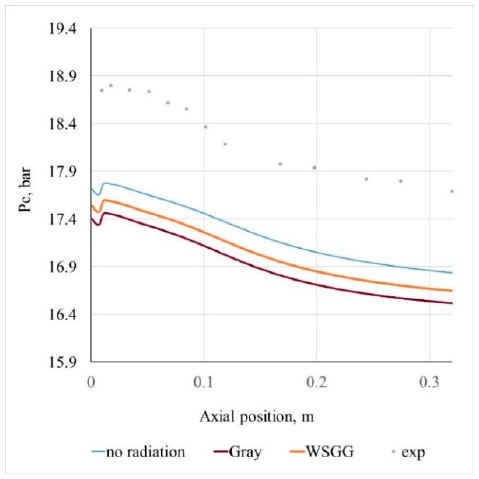
Figure 9. Absolute pressure axial distribution.